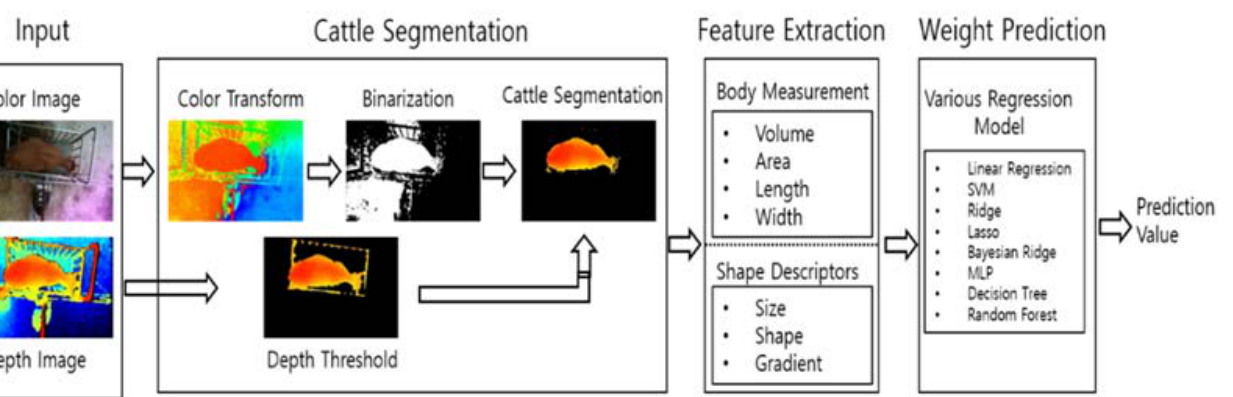
Figure 1. Sample images for male and female Korean cattle: ( a ) male; ( b ) female.